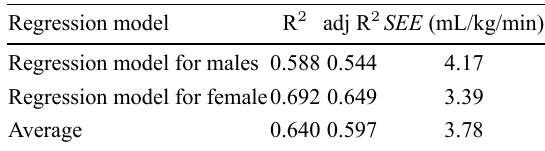
Table 7. Coefficient of determination (R 2 ) and standard error of estimate ( SEE ) in each regression